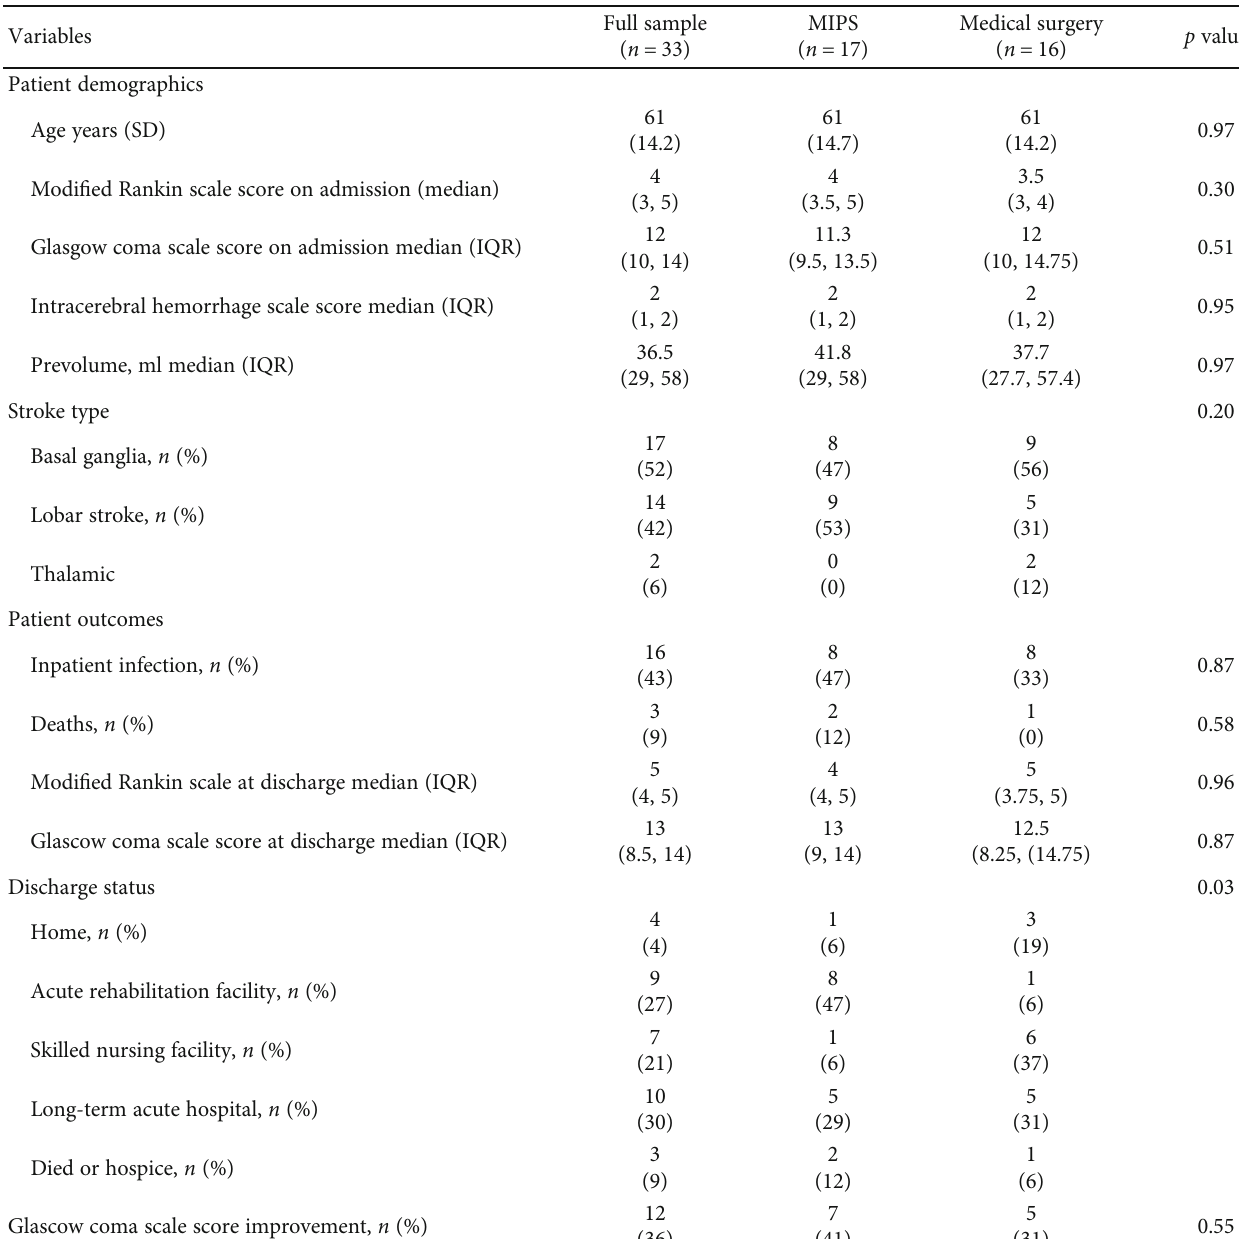
Table 4: Demographic, preclinical, and outcome data by minimally invasive parafascicular surgery (MIPS) and medical surgery.